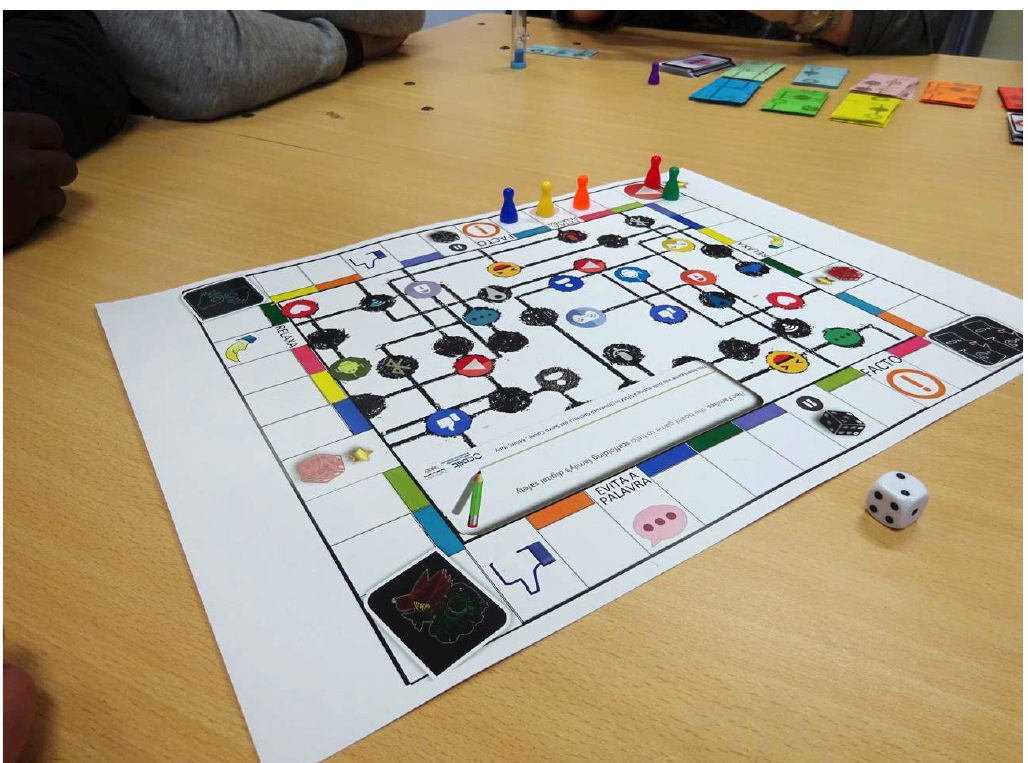
Figure 1. Boardgame. Source: Photo taken by an institutionalised